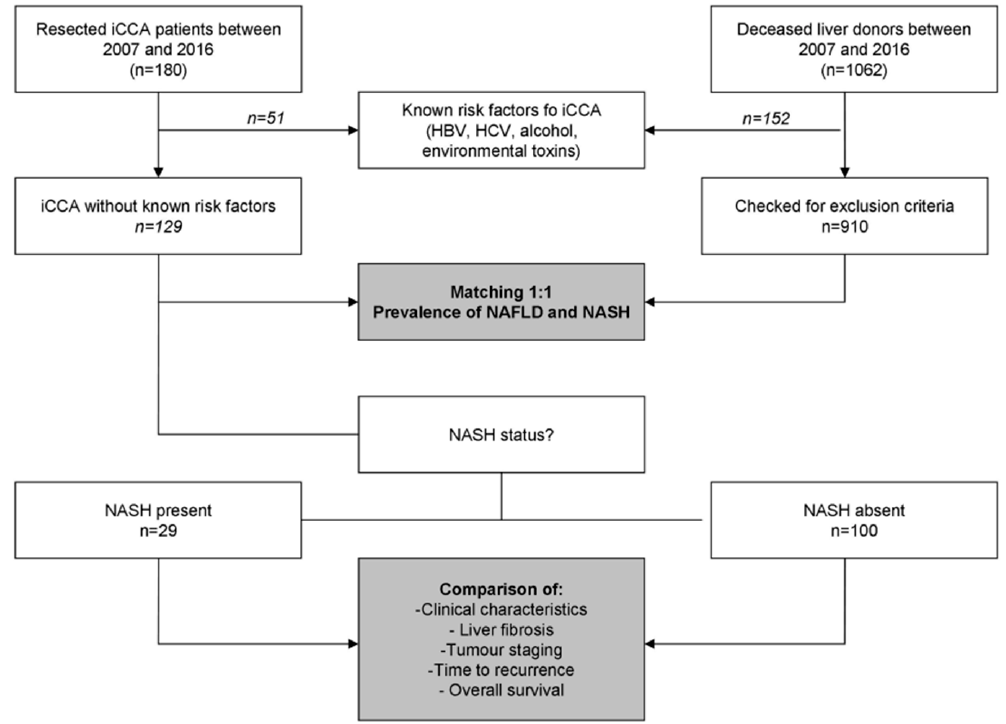
Figure 1. Patients disposition. iCCA, intrahepatic cholangiocarcinoma; NAFLD, non-alcoholic fatty liver disease; NASH, non-alcoholic steatohepatitis.